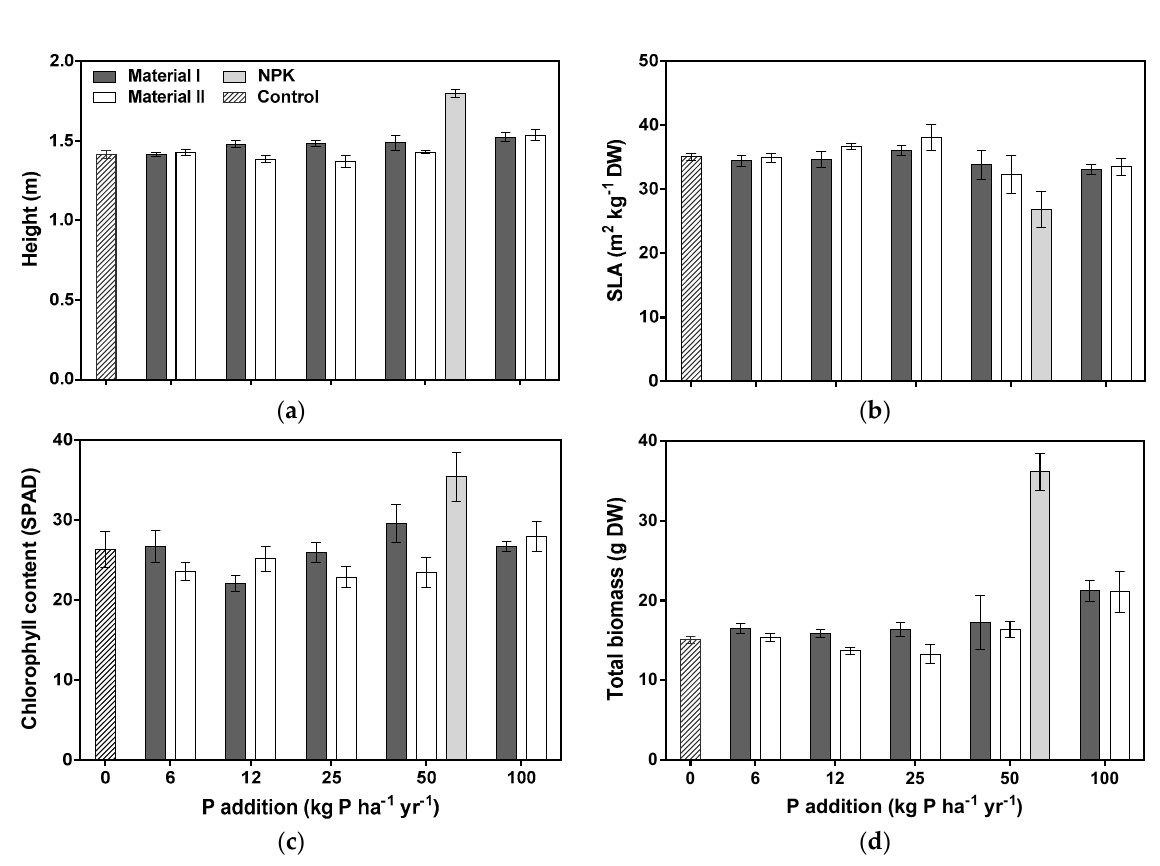
D.f. material = 1, d.f. P addition = 4, d.f. interaction = 4 and d.f. residual = 40 for all parameters, apart from d.f. residual for aboveground biomass P concentration, total P content in biomass and P concentration in soil after harvest of belowground biomass = 20. * p < 0.05; ** p < 0.01; *** p < 0.001; ns , not significant. a Total P content in biomass = tissue P concentration × tissue dry weight.